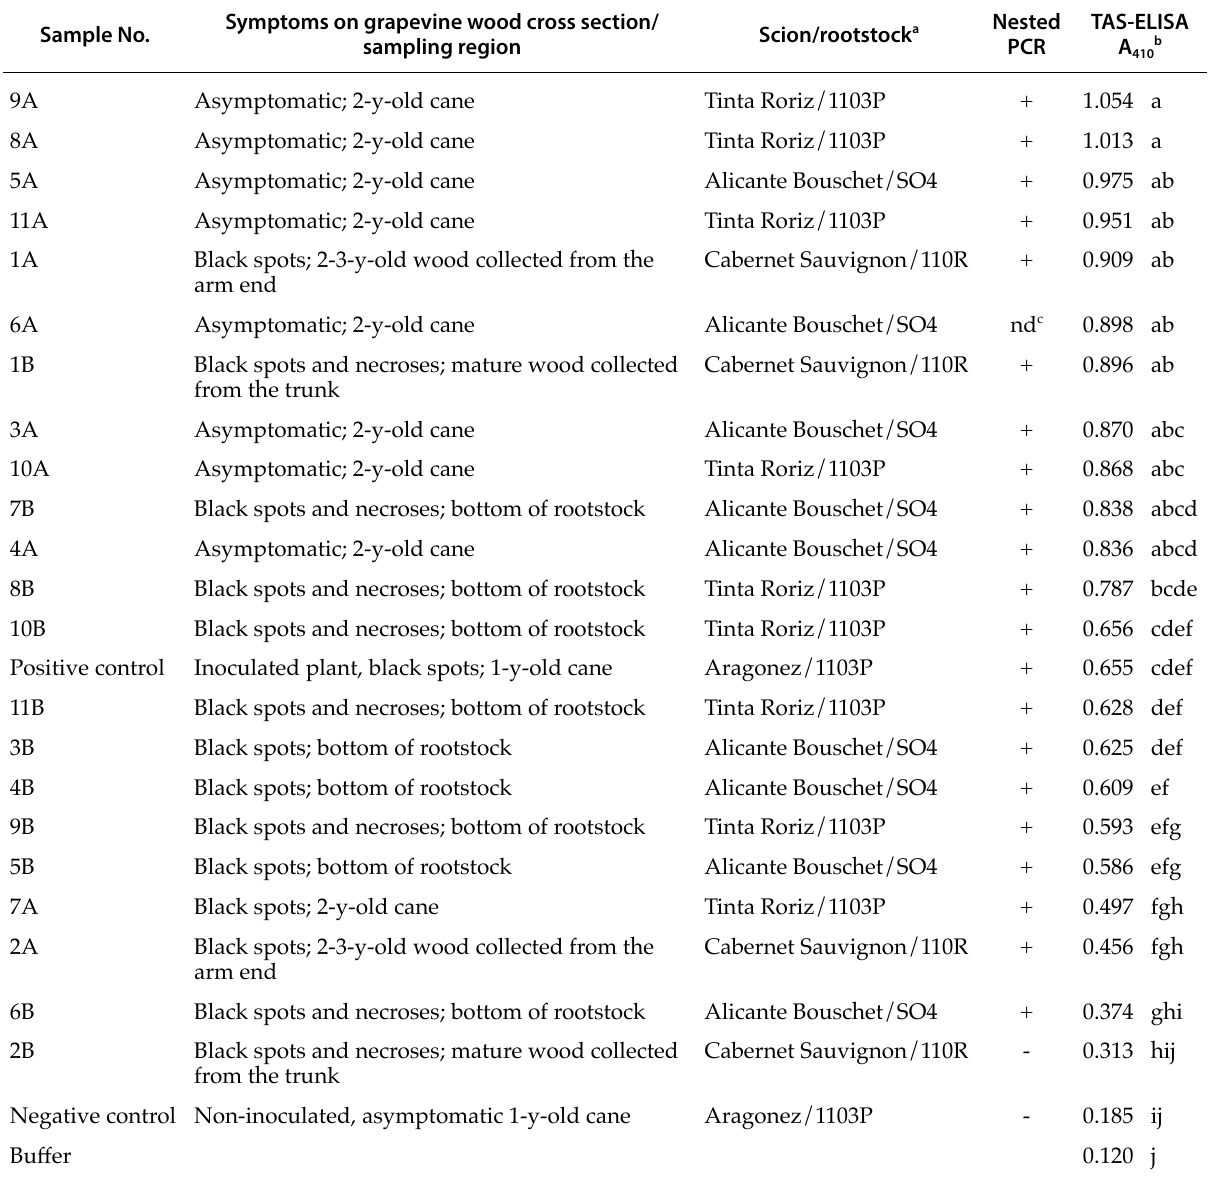
Table 2. Detection of Phaeomoniella chlamydospora in different samples of naturally infected grapevine plants, by nested PCR using species-specific primers, and TAS-ELISA using a monoclonal antibody (mAb116). Sample